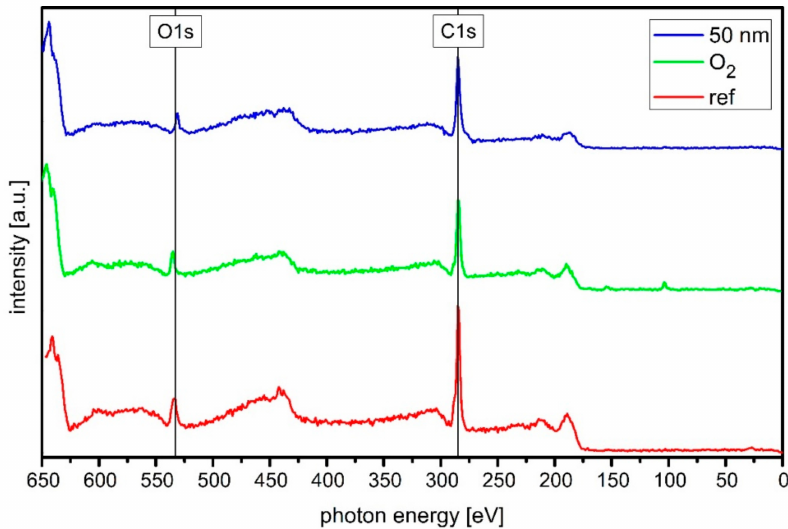
Figure 3. Full X-ray photoelectron spectroscopy (XPS) spectra of raw (red), O 2 treated (green) and 50 nm a-C:H layer coated PBAT sample (blue). The intensity variation of the oxygen peak as well as the shape of the C1s peak significantly changes as the treatment of the polymer surface